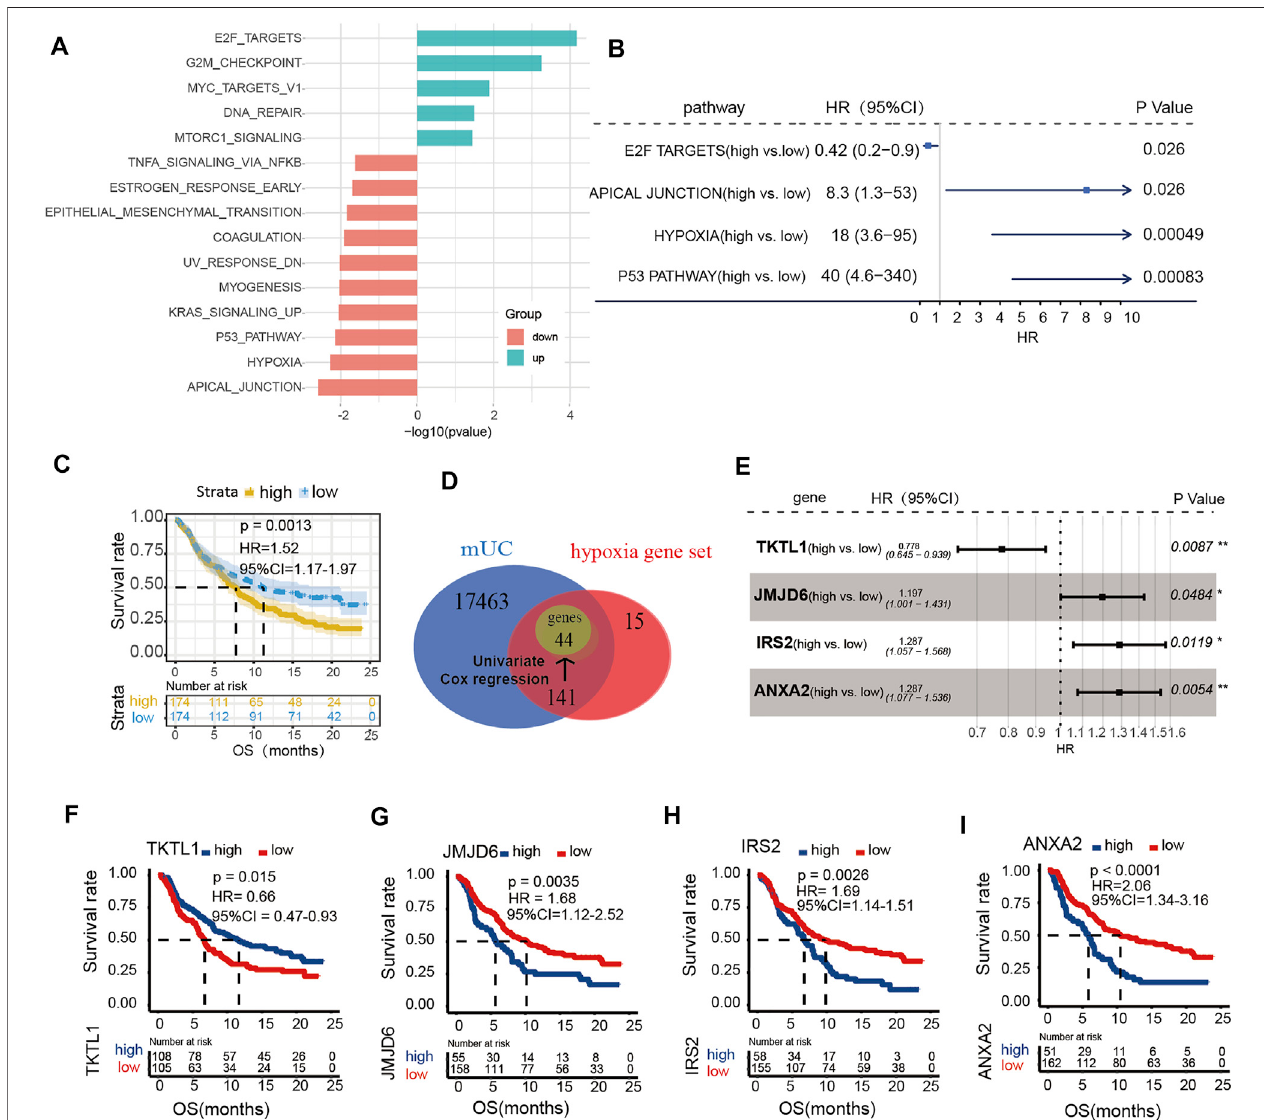
FIGURE 1 | The expression of hypoxia microenvironment in metastatic urothelial carcinoma (mUC). (A) Histogram showed that the ssGSEA score of the Hallmark pathway set was different in CR/PR vs PD/SD patients (logFC < 0, p < 0.05). (B) The enrichment scores of hypoxia gene set were different in forest map. (C) KM curve showed that patients with high score of hypoxia gene set had poor OS (log rank p < 0.05). (D) The gene in each data set was shown by Wayne map. The forest map shows the genes and coef fi cients of risk score.